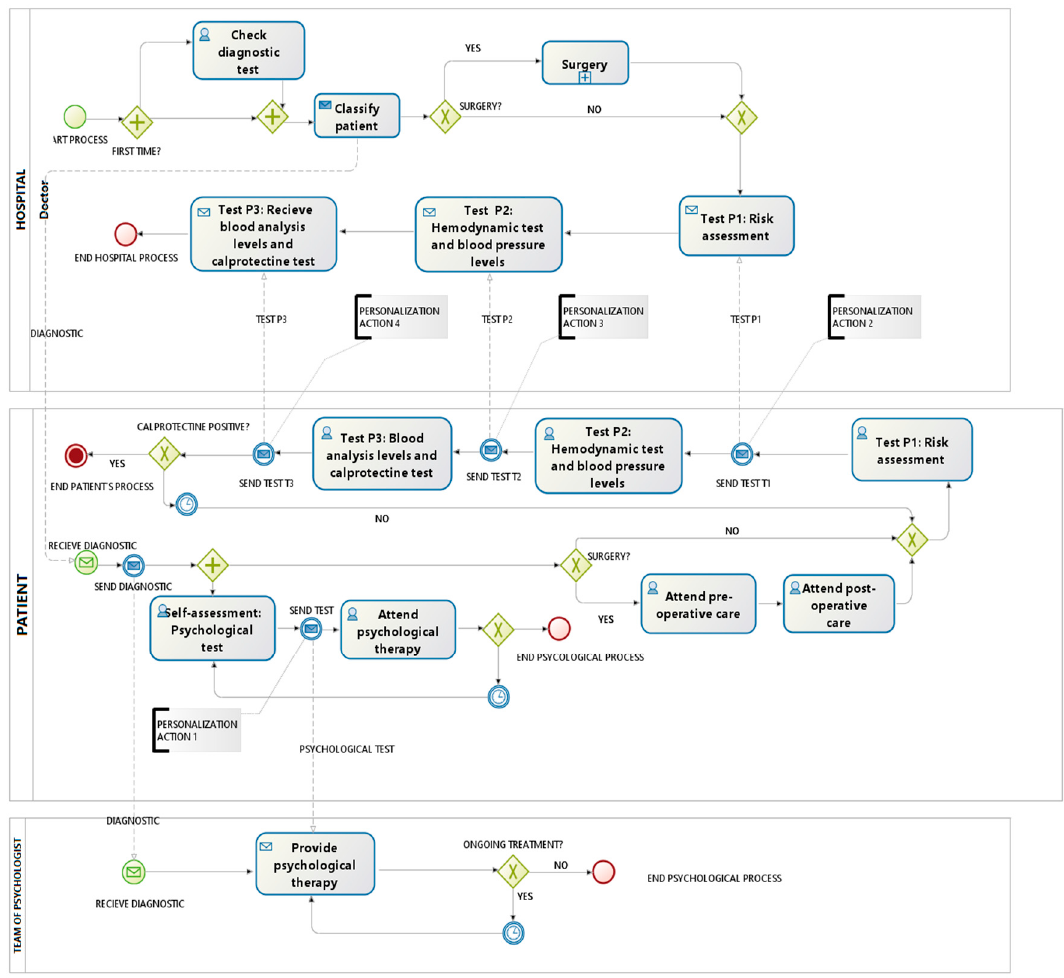
Figure 3. Proposed redesign process.